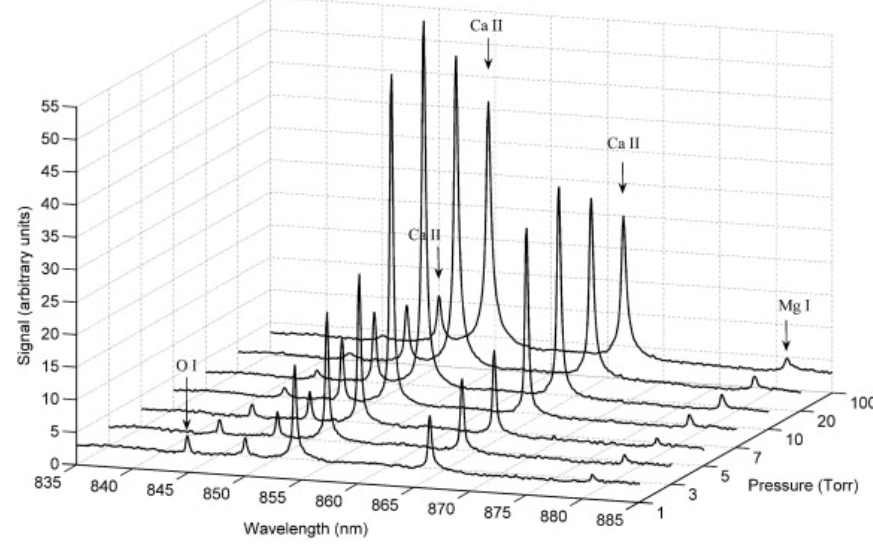
Figure 3. LIBS spectra of a geological sample (oolithic hematite) at various pressures. Reprinted from reference